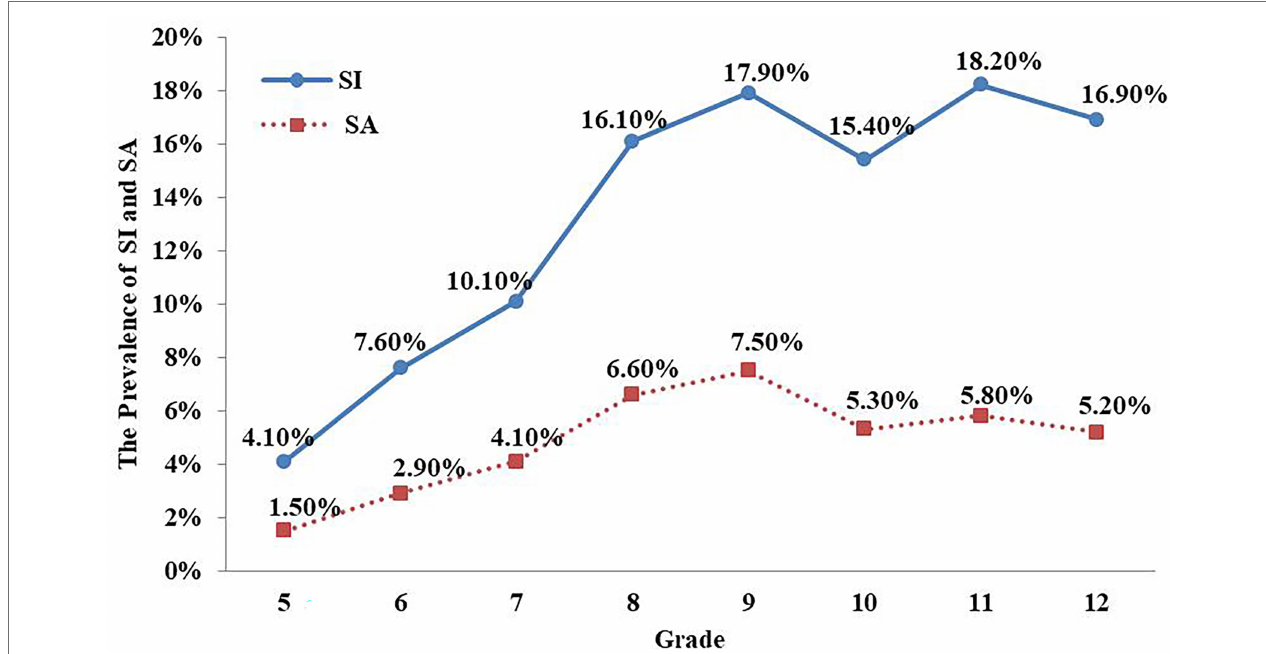
FIGURE 1 | The prevalence of SI and SA between different